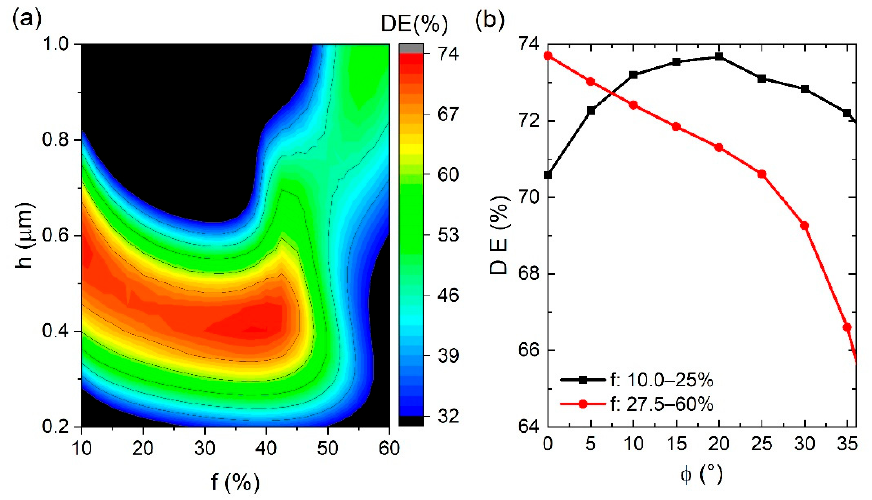
Figure 2. ( a ) Calculated GaP diffraction efficiency (DE) as a function of groove depth h and filling factor f , at perfect rectangular grating shape (wall angle, φ = 0 ◦ ) and ( b ) diffraction efficiency (DE) versus various wall angles φ , at λ p = 2.06 µ m, d = 1.7 µ m, and 3 THz phase-matching frequency for TE polarization state.